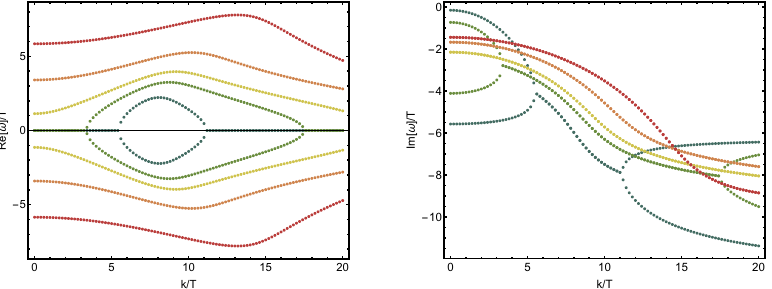
Figure 6 . The two lowest modes in the transverse spectrum of the (cid:13)uid model (3.1) for m=T 2 [0 : 67 ; 6 : 28] (from blue to